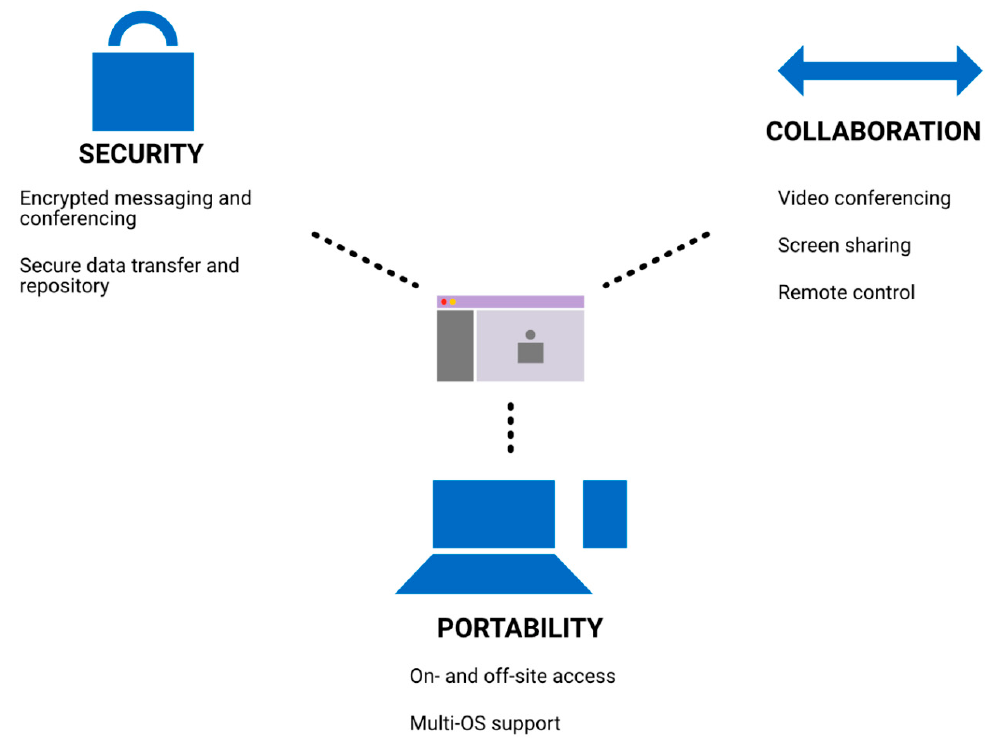
Figure 2. Virtual review software features. We identified three domains that allowed for the success of virtual contouring review, including security, collaboration, and portability.